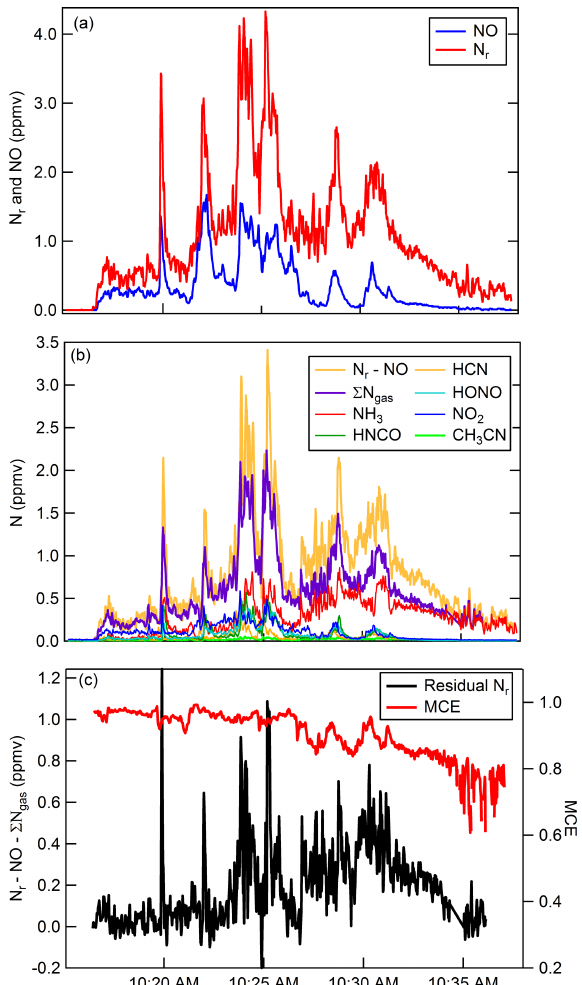
Figure 7. Time series for Fire Sciences Lab 2016 measurements of emissions from a subalpine fir canopy sample (Fire 047). (a) To- tal reactive nitrogen (N r , red) and nitric oxide (NO, blue) measure- ments. (b) Comparison of the difference (N r -NO, gold) with the sum of the measured gas-phase N r species (purple). The sum of individually measured gas-phase species in order of abundance in- clude NH 3 , HNCO, HCN, HONO, NO 2 , CH 3 NO 2 , and 40 minor organic nitrogen species. NO 2 and HONO were measured with a broadband cavity-enhanced extinction spectrometer, HCN and NH 3 were measured with a FTIR spectrometer, and all remaining organic species were measured with a H 3 O + CIMS. (c) Residual N r (black) in parts per million volume with modified combustion efficiency overlaid (MCE,